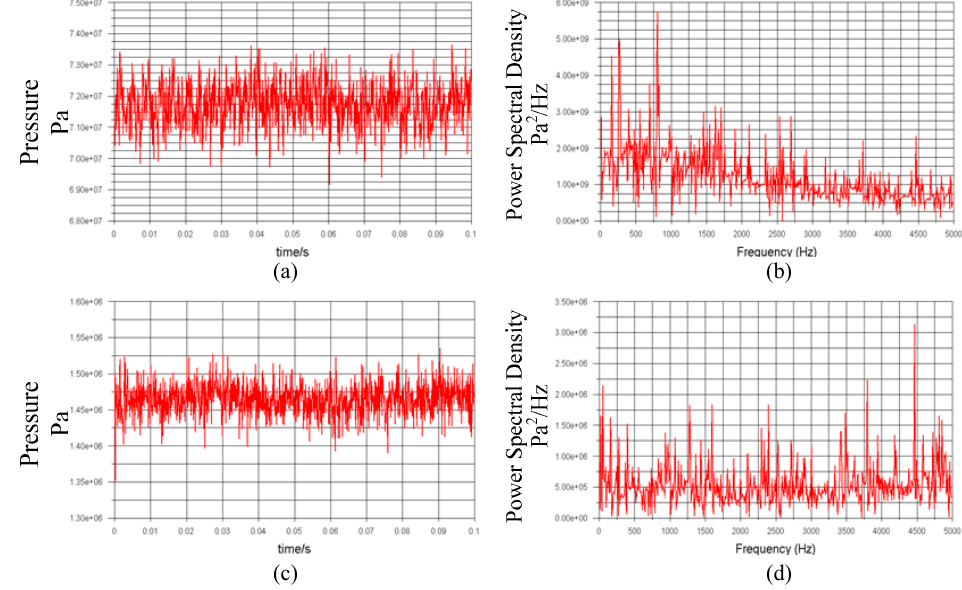
Figure 15. Pressure oscillation curve of the flapper when the displacement of the flapper is x = 0.15 mm. ( a ) Point 1 in the time domain. ( b ) Point 1 in the frequency domain. ( c ) Point 2 in the time domain. ( d ) Point 2 in the frequency domain.